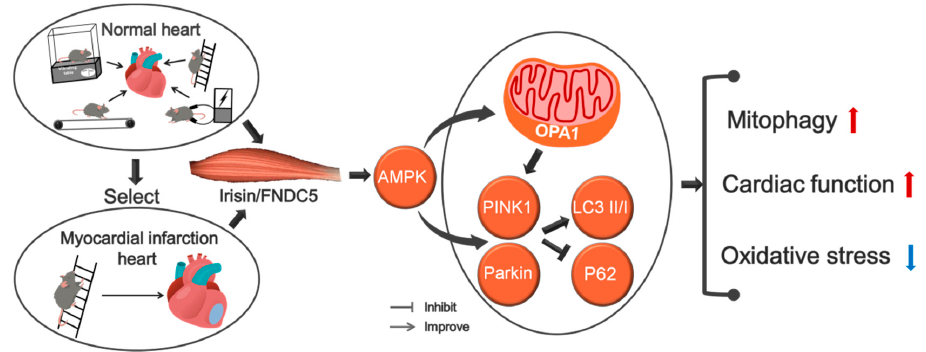
Figure 9. Resistance exercise mediated by Irisin enhanced mitophagy and improved cardiac function.